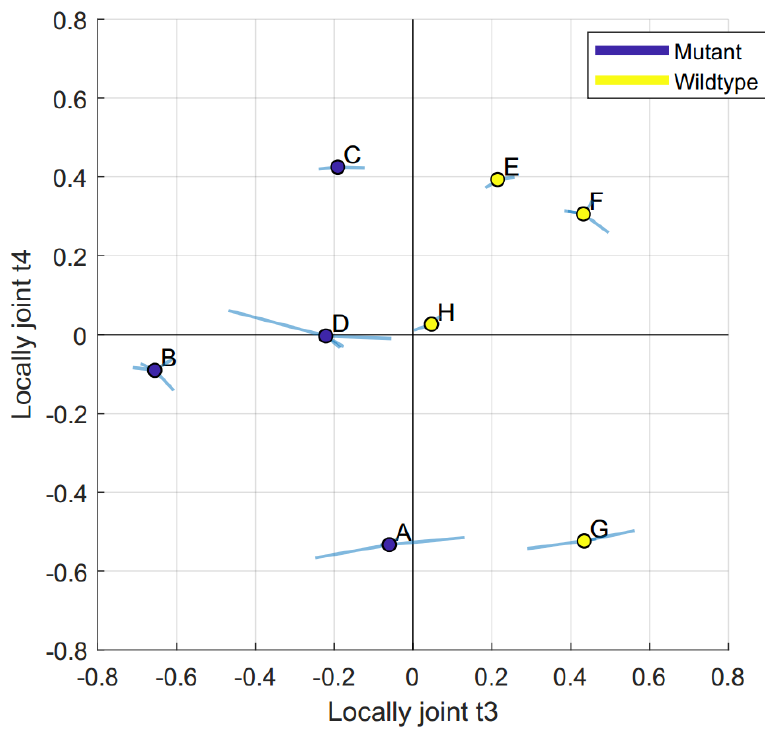
Figure 3. JUMBA multiblock scatter plot t3 vs. t4. The multiblock scatter plot was used to summarize locally joint components t3 and t4. The centre scatter circle represented the average score for each mouse and the whiskers represented how much each tissue type differed from this average. The circles were colored according to the genotype, showing that the locally joint t3 separates mutants from the wild type.